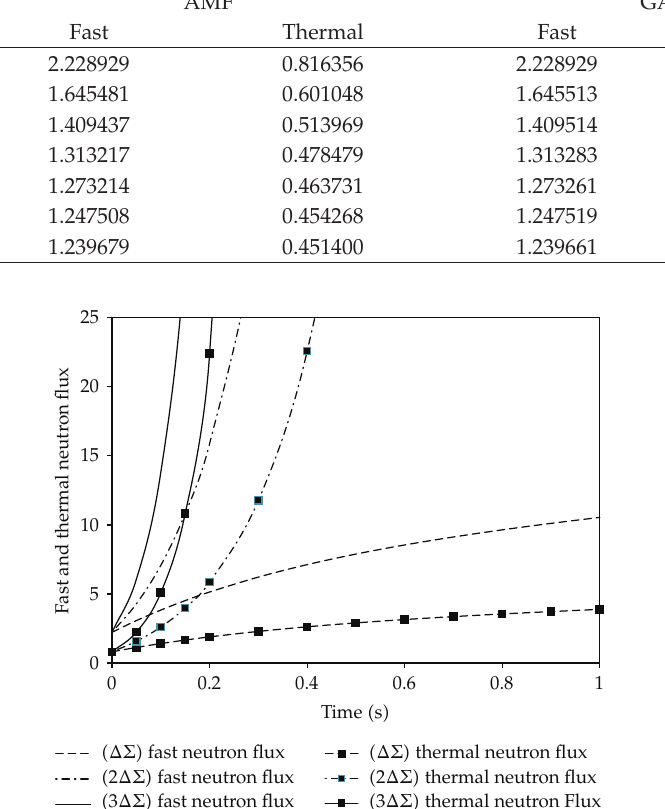
Figure 1: Fast and thermal neutron flux at a positive step